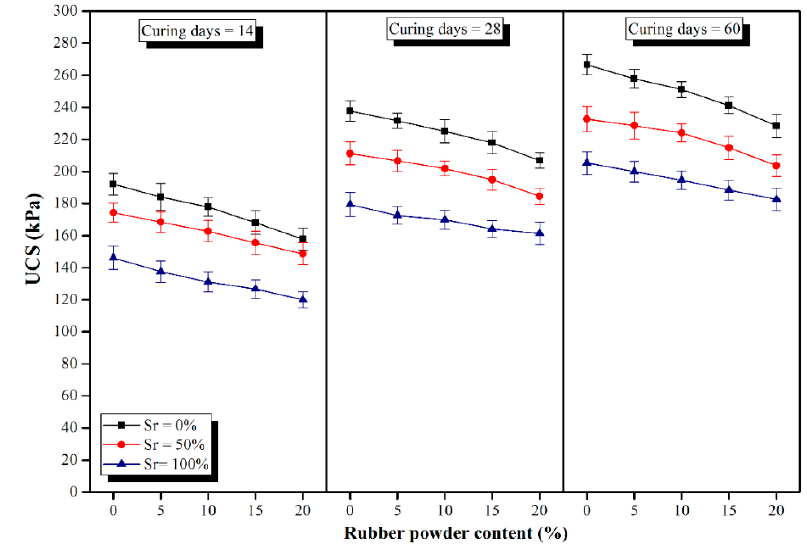
Figure 6. UCS values of Group B samples versus various rubber powder contents at different curing days and saturation degrees.